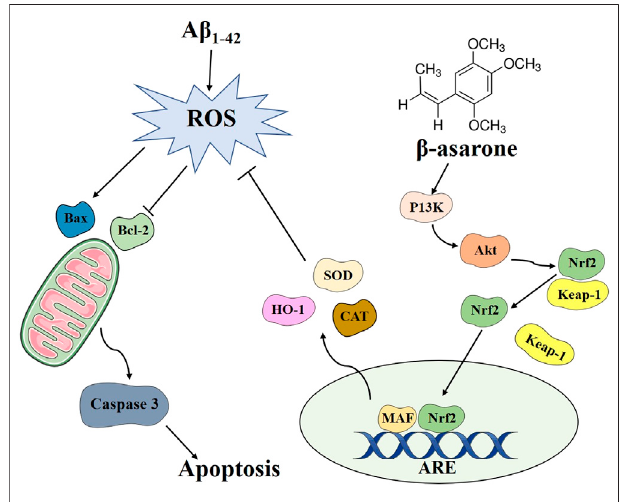
FIGURE 7 | Schematic diagram of the possible mechanism underlying the neuroprotective effects of β -asarone on PC12